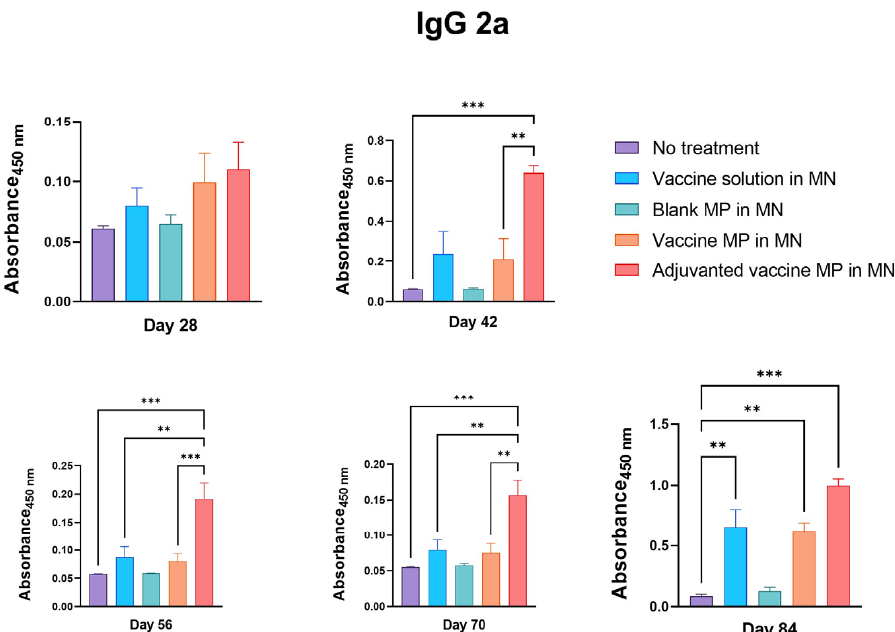
Figure 5. Measurement of Zika-specific IgG2a in serum using ELISA. Mice were immunized via transdermal route with one prime dose on day 0 and two booster doses on days 15 and 29. Mice receiving adjuvanted vaccine MPs induced significantly higher antibody titers than the untreated control group (days 42, 56, 70, and 84). Moreover, the group receiving adjuvanted MNs showed higher titers than the group receiving vaccine MPs without adjuvants (days 42, 56, 70). Seven days after the challenge with live virus, mice receiving vaccine solution, vaccine MPs, and adjuvanted vaccine MPs induced significantly higher antibody titers than the untreated control group (day 84). (data presented as mean ± SEM, n = 5, One-Way ANOVA test followed by Tukey’s multiple comparison test; **, p < 0.01, ***, p <